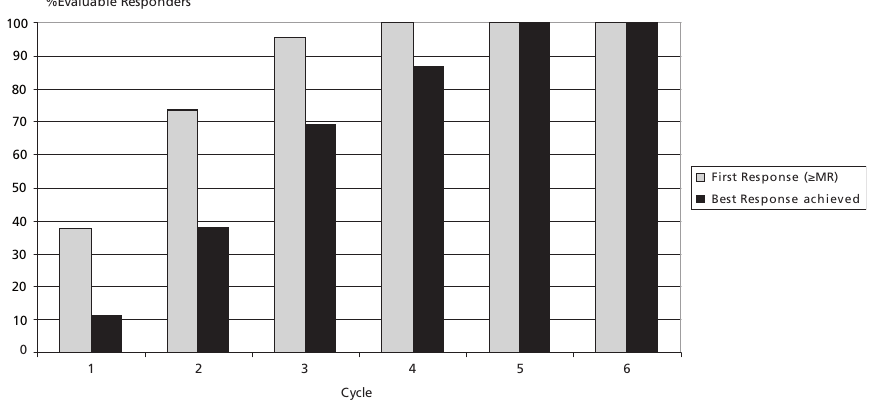
Figure 1 Cumulative percent- age of first response ( ≥ MR, blue) and best response (marker nadir level, red) achieved at each bortezomib